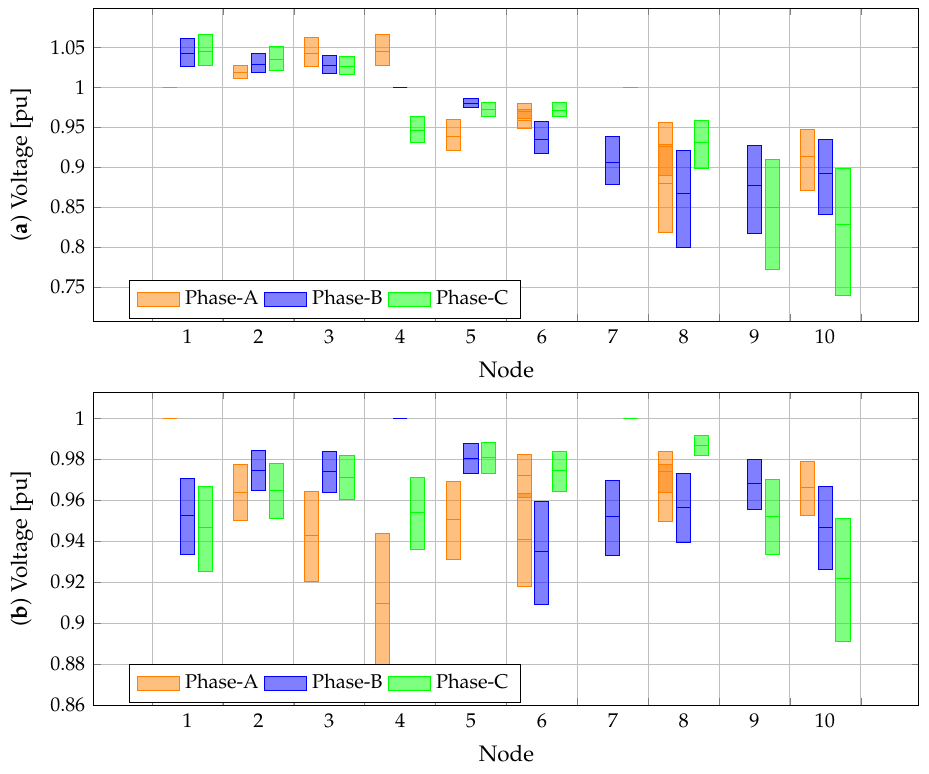
Figure 6. Voltage in generation and demand nodes: ( a ) Before phase-balancing and ( b ) after